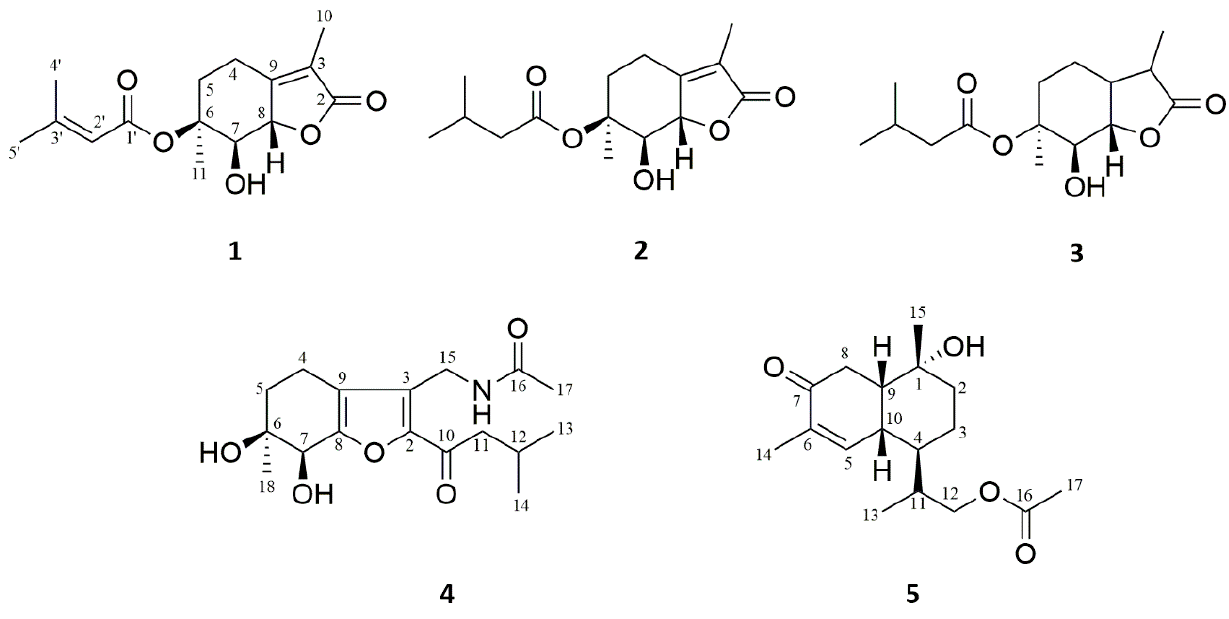
Figure 1. Structures of compounds 1 – 5 .